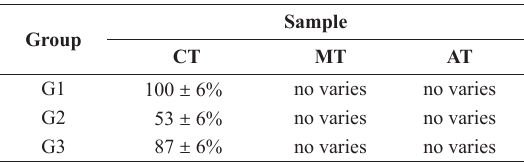
Figure 3. Free radical EPR spectrum of CT, MT and AT of G1 with a MgO:Mn 2+ standard sample. Table 3. Relative concentration of free radicals in the samples 10 min after mixing base paste and